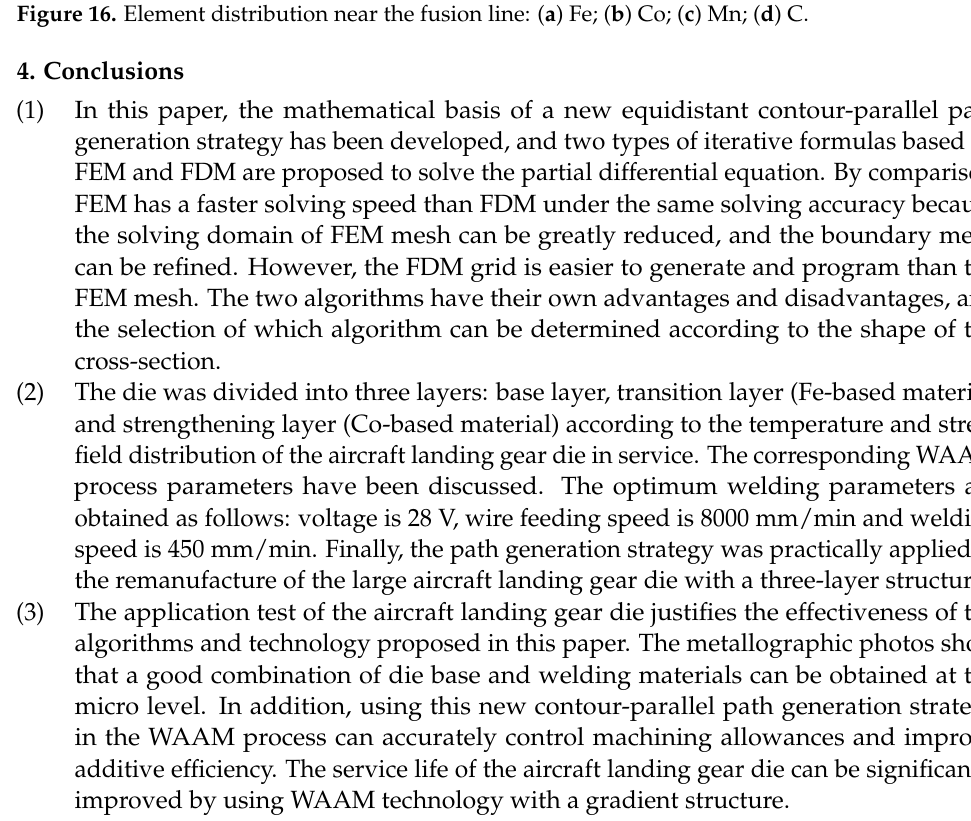
Figure 16. Element distribution near the fusion line: ( a ) Fe; ( b ) Co; ( c ) Mn; ( d )